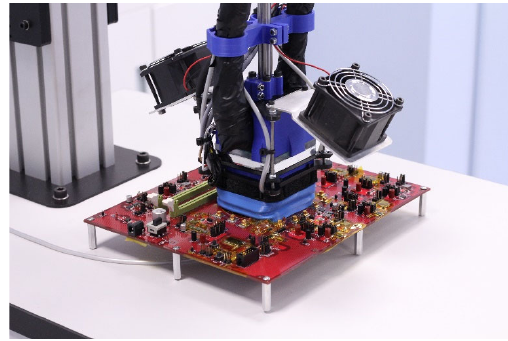
Figure 5. Socket ‐ based test setup mounting option.